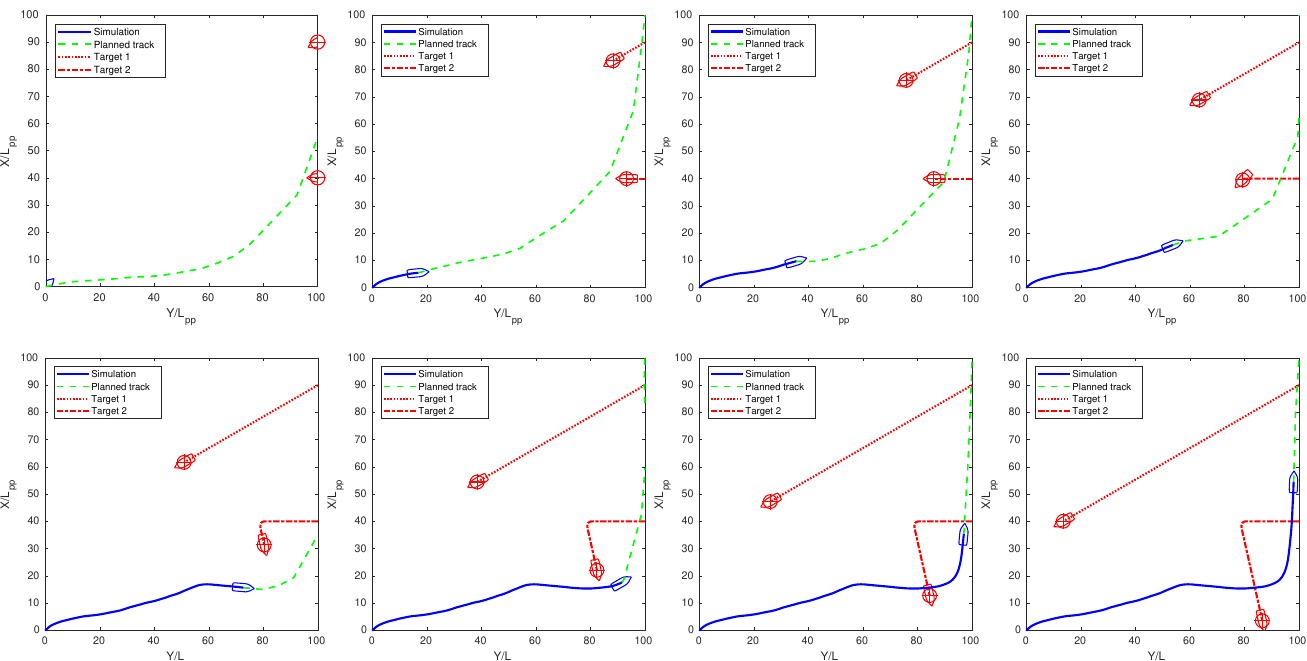
Figure 14. Scenario 2: simulation of a COLREG-compliant manoeuvre with unexpected target behaviour (major course change).